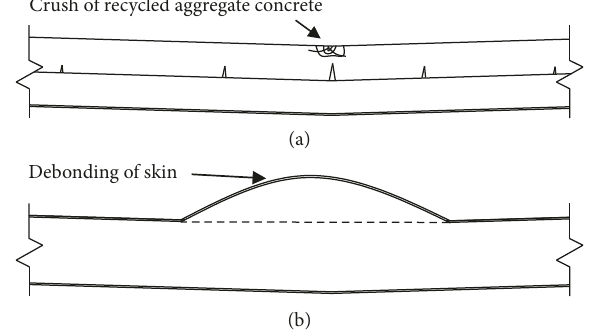
Figure 11: Load-strain relationships. The bar graphs are presented as mean SD ( n 5). (cid:31) ±